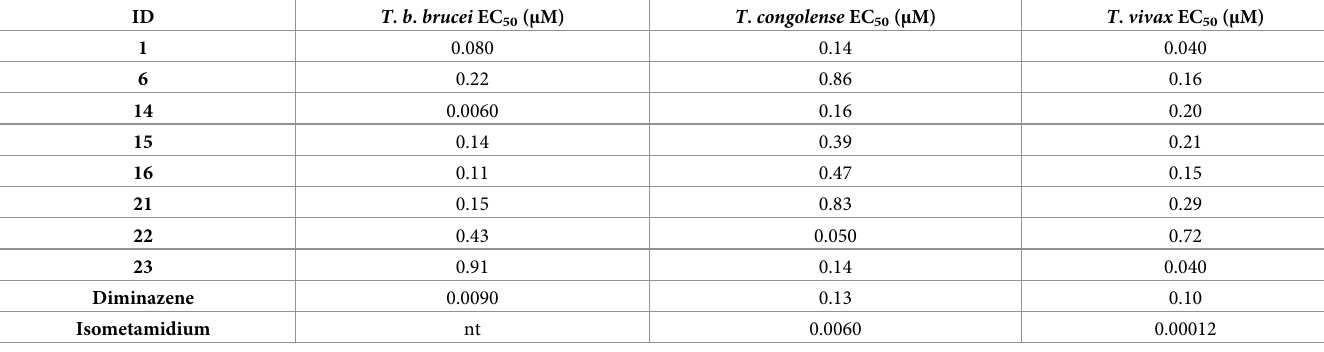
Table 1. Biological activity against T . congolense and T . vivax .